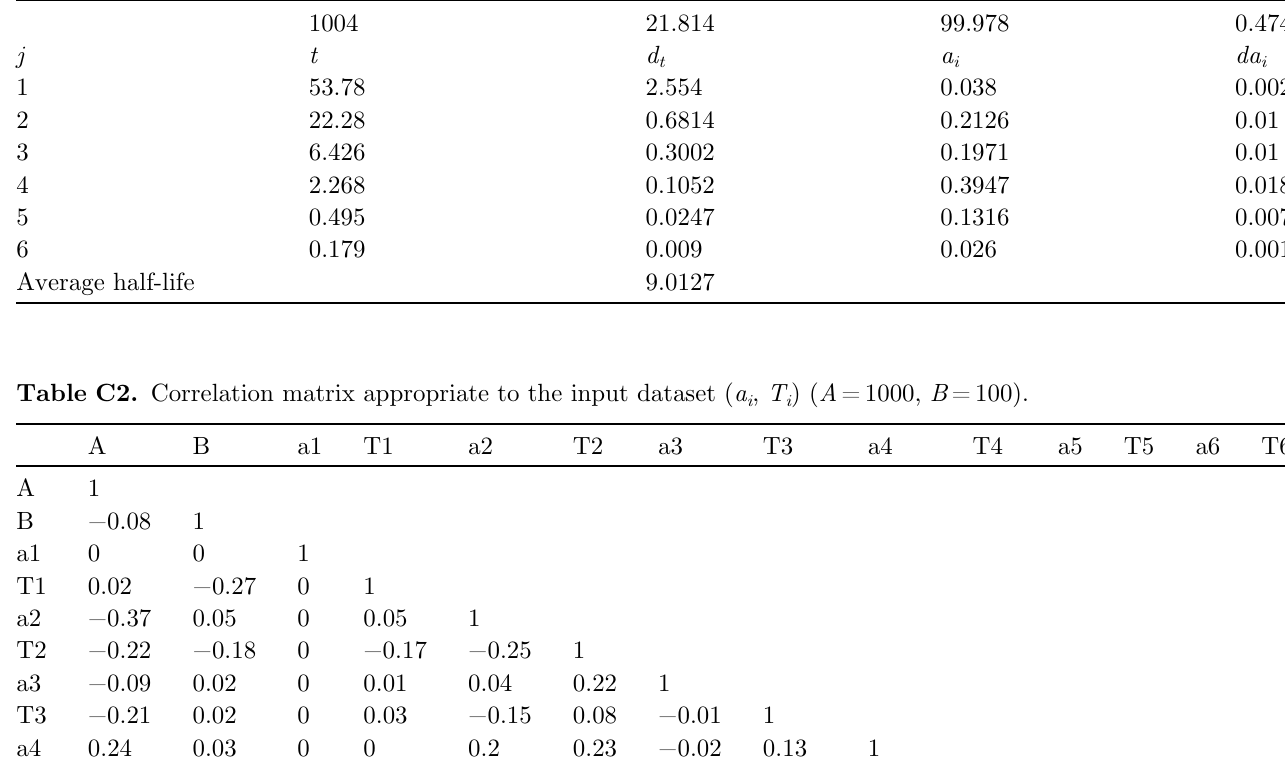
Table C1. “ Input dataset ” for testing the quality of generation of correlation matrices ( A = 1000, B = 100).